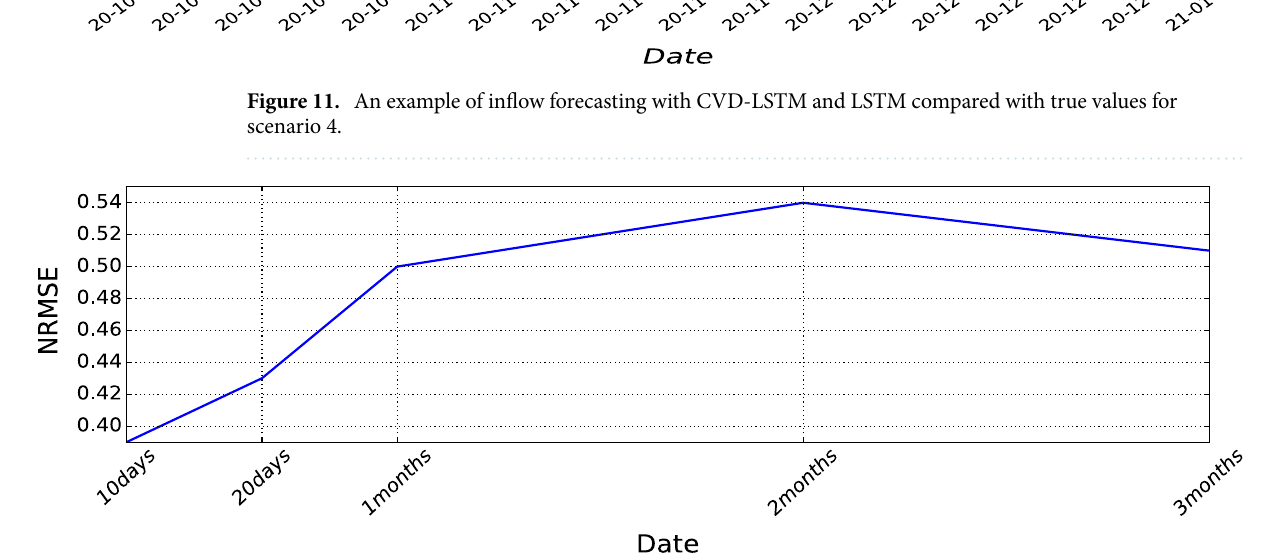
Figure 12. Model performance drift over different sequential day-ahead forecasting